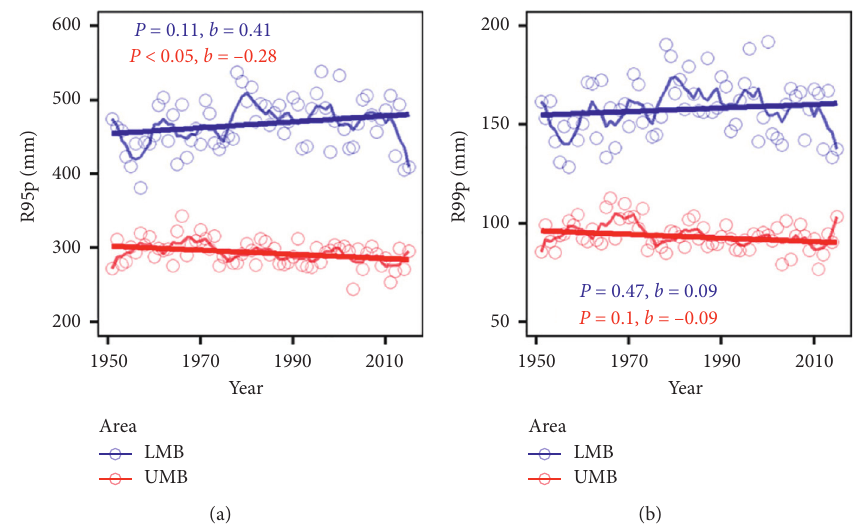
Figure 5: Temporal trends in R95p and R99p averaged across the UMB and the LMB over 1951–2015. The lines represent linear trends of precipitation indices, and the polylines indicate the five-year moving averages of the indices.